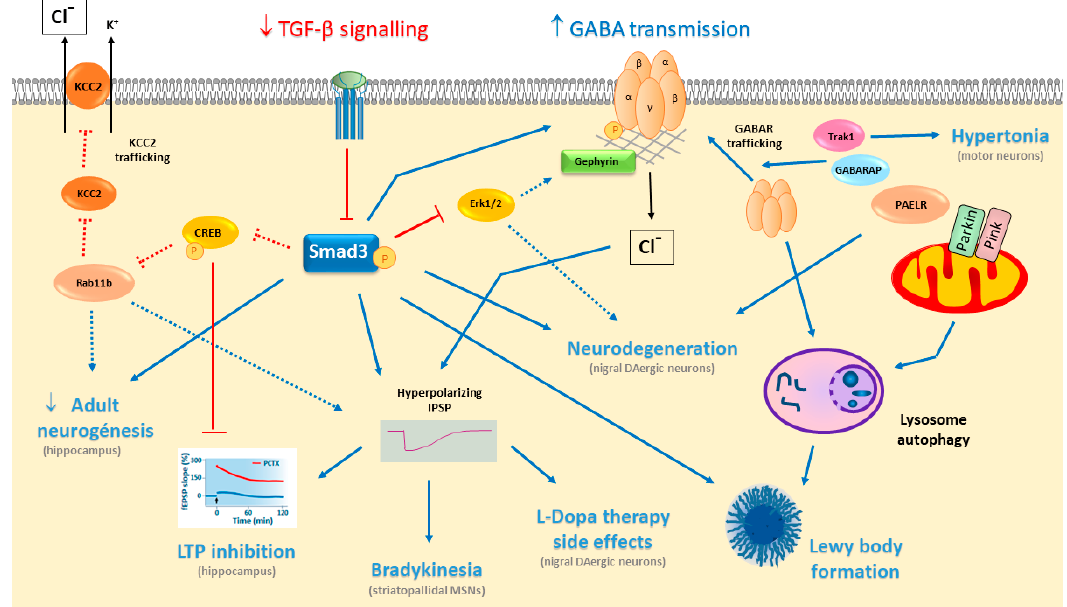
Figure 2. Illustration of the working model of TGF- β signaling and GABA neurotransmission interaction in the context of PD. Arrows indicate induction and T-bars inhibition. Dotted arrows and dotted T-bars suggest possible interactions, not yet shown experimentally and derived from the bibliographic